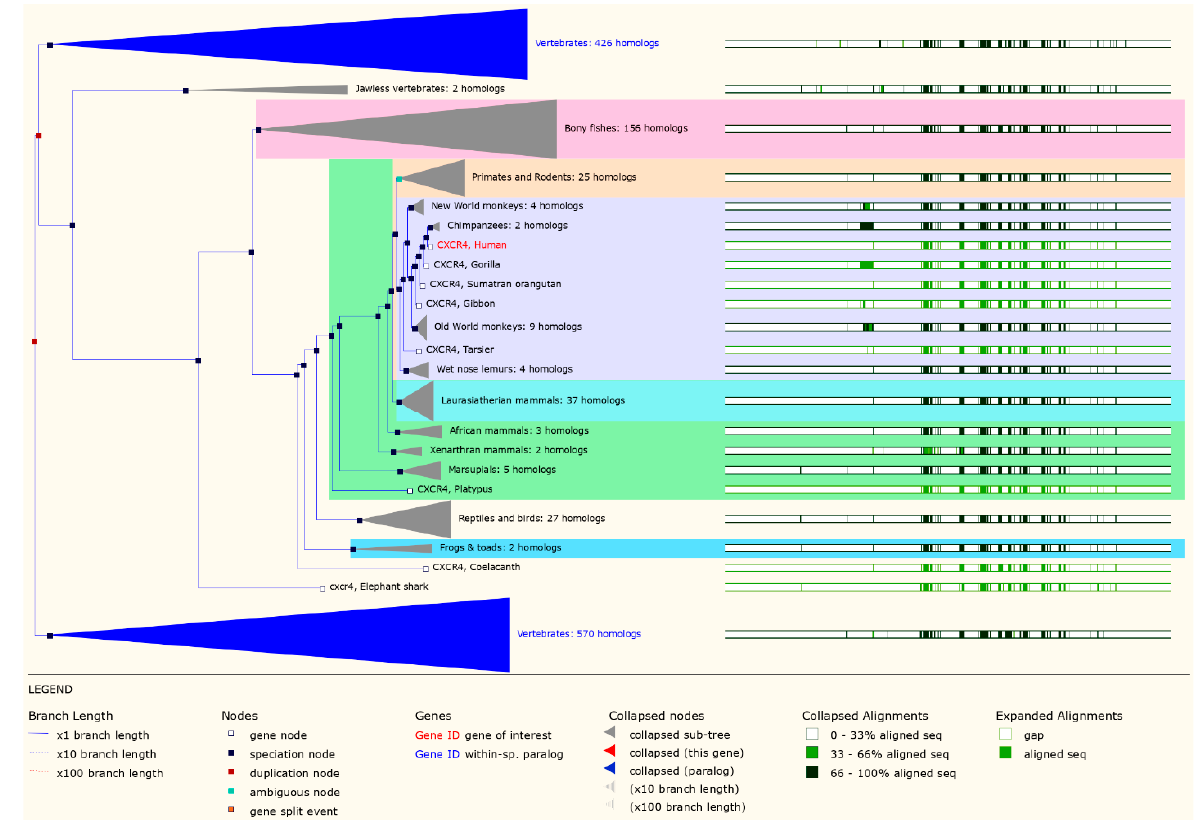
Figure 1. The phylogenetic tree with the highest likelihood represents the evolution of the CXCR4 gene. The red boxes represent gene duplication events, and the blue boxes represent speciation events. In the alignment of domains, the green and black bars represent the conserved and variable regions of the CXCR4 protein, respectively.